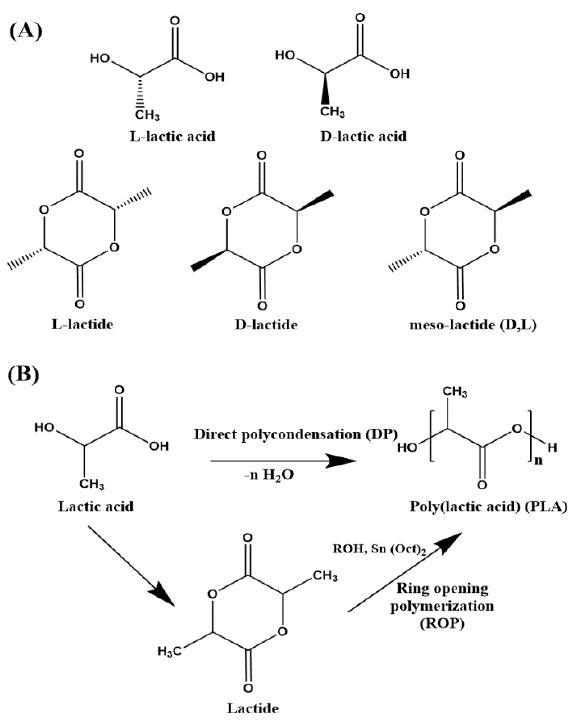
Figure 1. ( A ) Chemical structures of L -lactic acid, D -lactic acid, L -lactide, D -lactide and mesolactide, ( B ) Schematic representation of direct polycondensation (DP) of lactic acid and ring opening polymerization (ROP) of lactide.